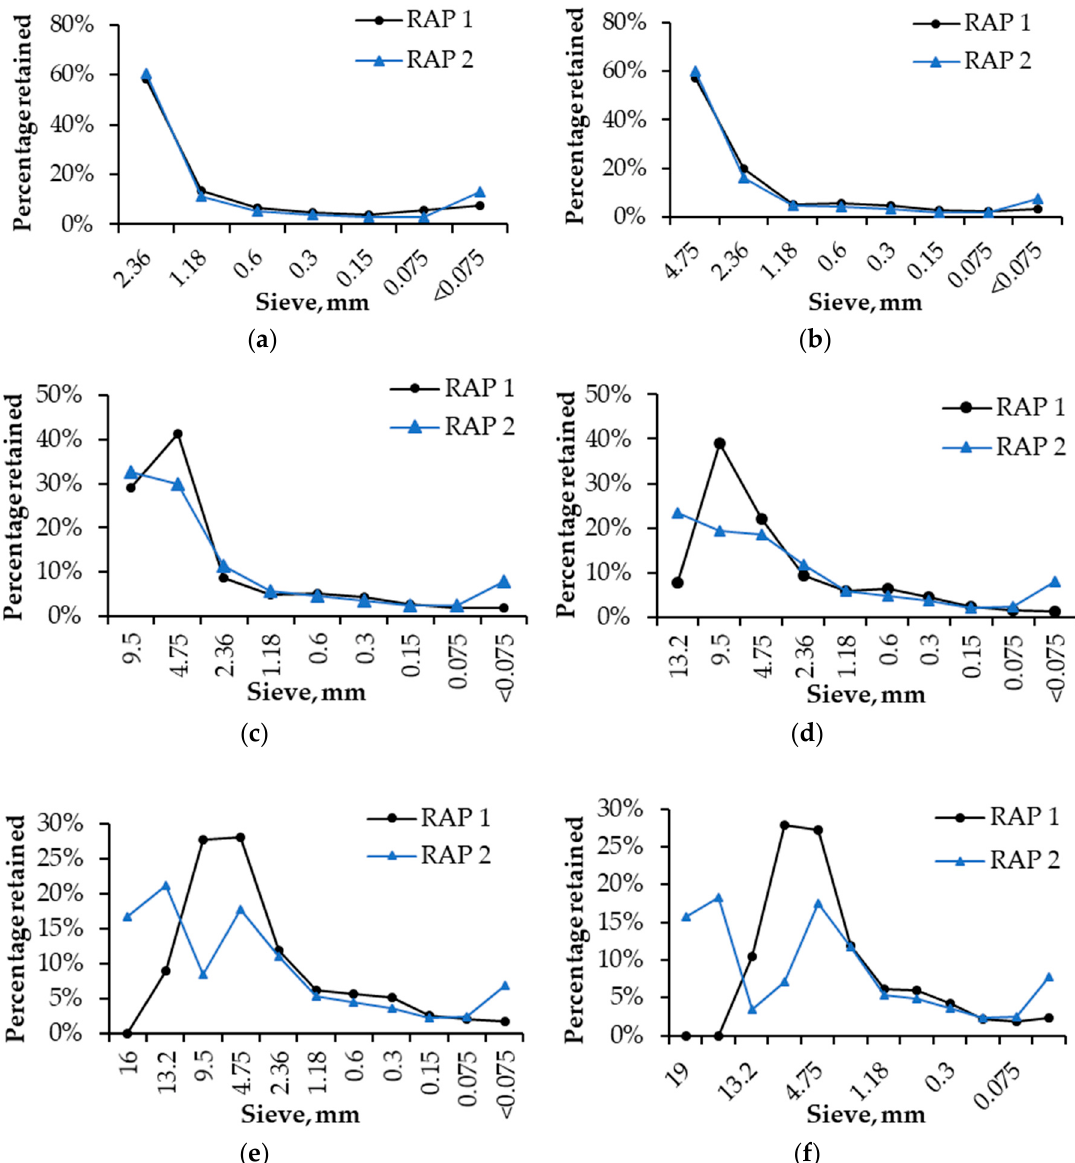
Figure 4. The Percentage Retained of Each Sieve after the Extraction Test, ( a ) 2.36 mm sieve; ( b ) 4.75 mm sieve; ( c ) 9.5 mm sieve; ( d ) 13.2mm sieve; ( e ) 16 mm sieve; ( f ) 19 mm sieve.